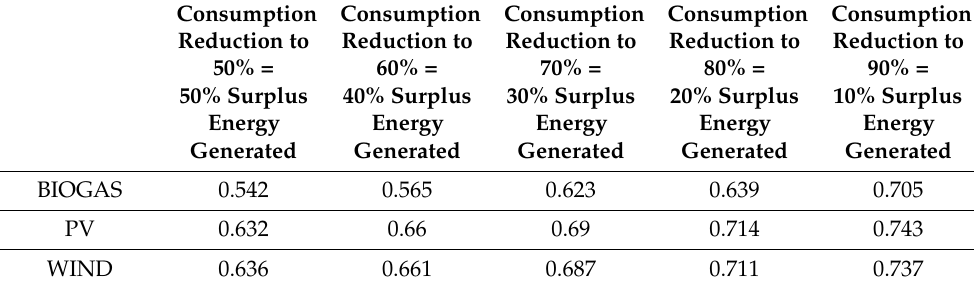
Table 4. Network deposit load